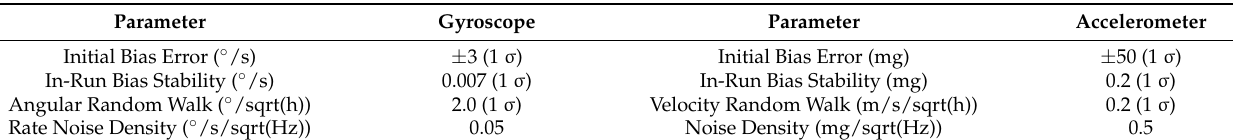
Table 1. Specifications of Analog Devices ADIS16405. The σ is one sigma (confidence level).